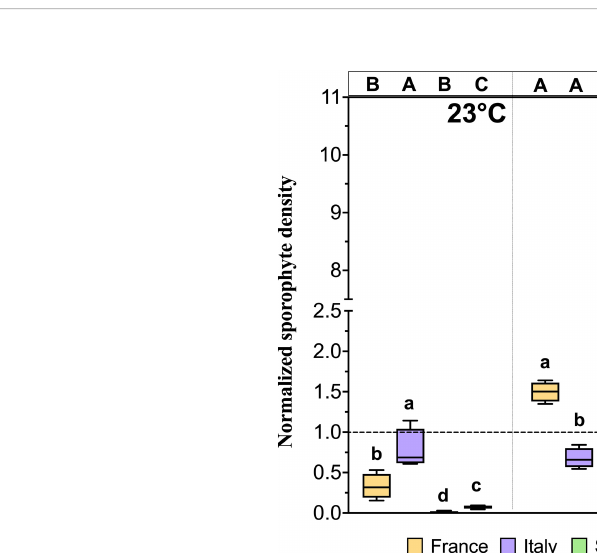
The post-hoc results are presented in Figure